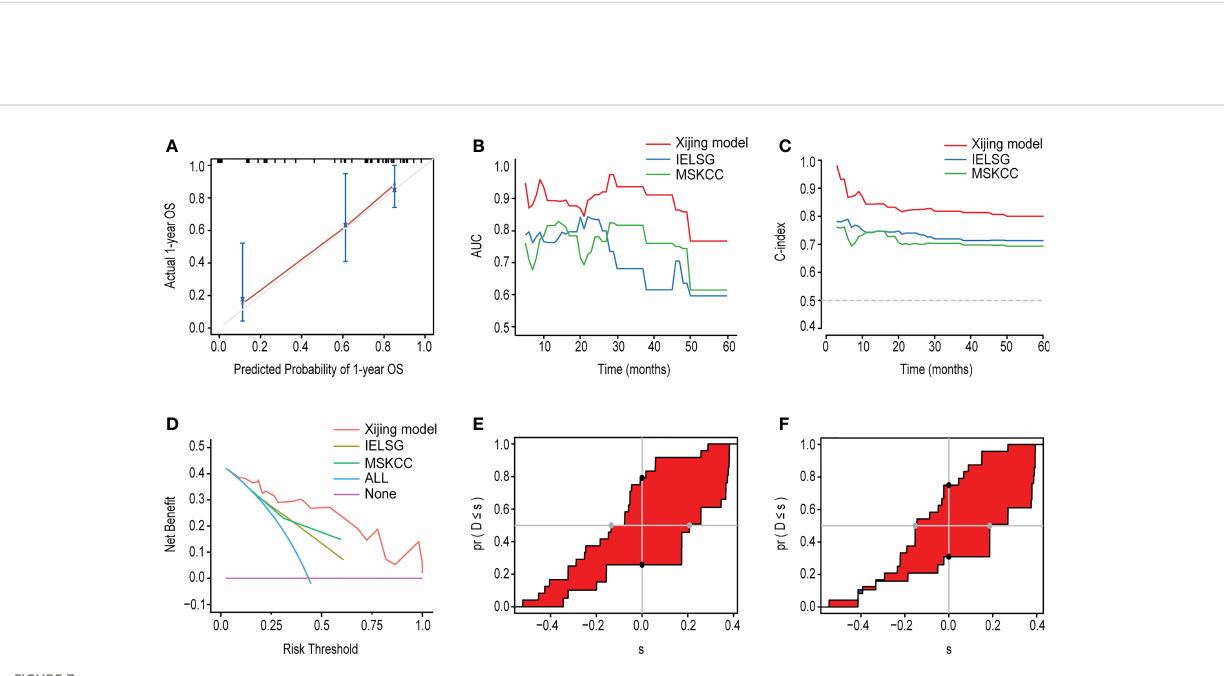
FIGURE 7 The performance of the Xijing Model, IELSG and MSKCC scores for predicting OS in the validation cohort. (A) The time-dependent AUC of the three models. (B) The time-dependent Harrell ’ s C-index of the three models. (C) The DCA was used to estimate clinical usefulness of the three models for predicting 1-year OS. (D) The improvement in prediction of the Xijing model compared to the IELSG (E) and MSKCC (F) scores. The IDI is the value of the difference in area between red and blue zones. The continuous NRI is the value of the distance between two black